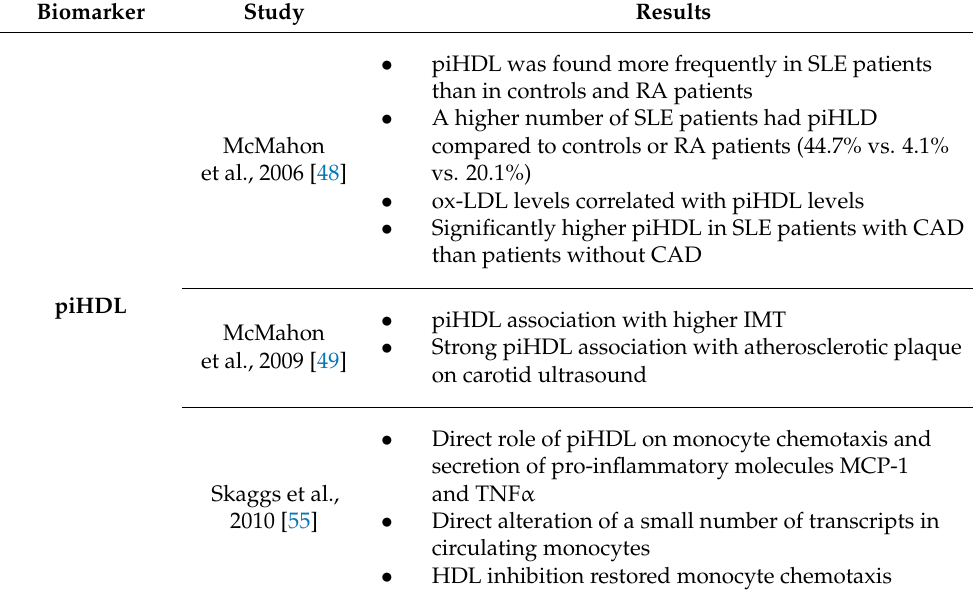
Table 1. Pro-inflammatory HDL in SLE